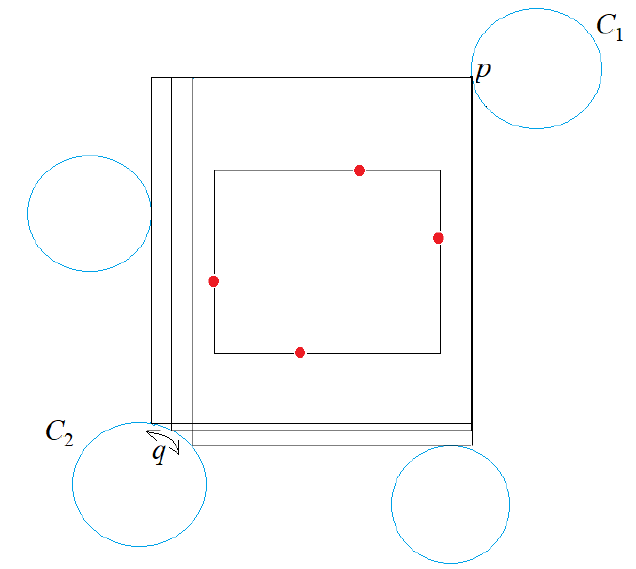
Figure 20. Case 4.2: No edge is pinned by any circle, and the position of p on C 1 ∈ NE quadrant is known. While sliding the CSR left-downward from S min , we first touch circle C 2 at a corner q opposite to p . There are an infinite number of CSRs in this